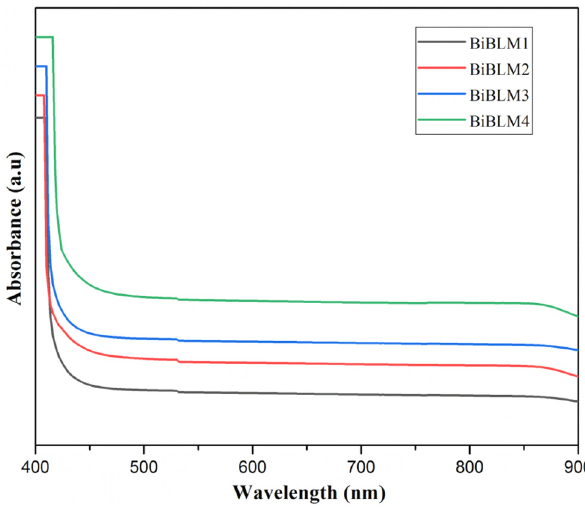
Figure 6. Optical absorption spectra of BiBLM glass system. Table 5. Optical parameters of BiBLM